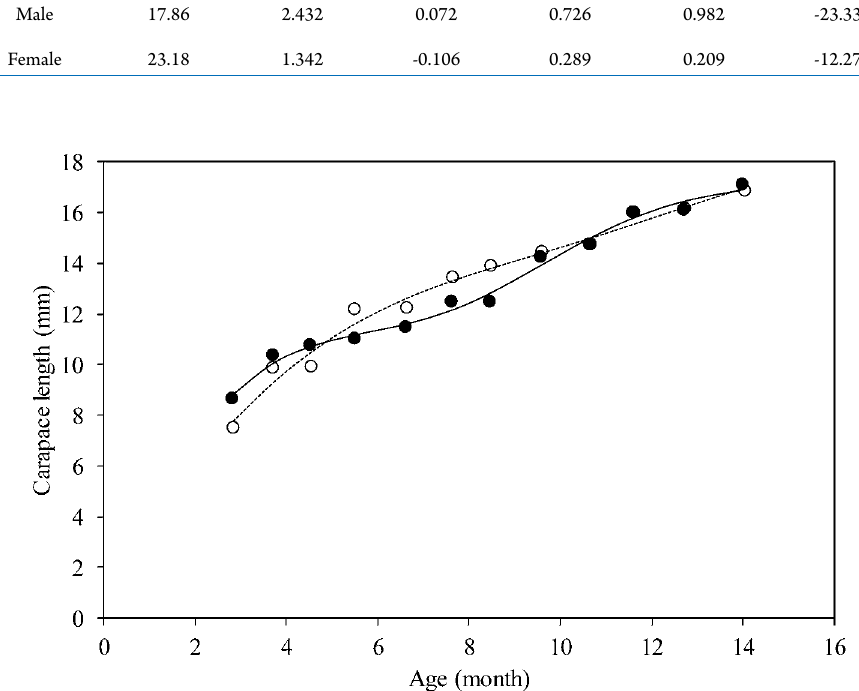
Figure 4. Growth curves for male and female Macrobrachium lamarrei collected from a wetland, northeastern Bangladesh during October 2016 to September 2017. Solid circles with solid line indicate males and open circles with dashed line indicate